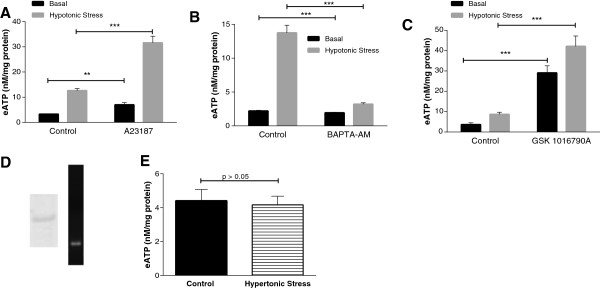
Roles of Ca2+ signaling and transient receptor potential vanilloid 4 (TRPV4) channels in hypotonically-induced release of eATP from chondrocytes. For the following experiments, chondrocytes were incubated with each additive for 30 minutes in 100 μl of media with no additives acting as a control. A hypotonic challenge was initiated by removing 35 μl of media, replacing it with 35 μl of H2O. eATP levels were measured after 10 minutes. Bars represent mean ± standard error. Under control conditions, a hypotonic challenge consistently increases (eATP). (A) Chondrocytes were incubated with 100 μM A23187, which increased eATP levels (n = 8; **P <0.01, ***P <0.001). (B) Chondrocytes were incubated with 10 μM bis-N,N,N',N'-tetraacetic acid-AM (BAPTA-AM), which decreased eATP levels after hypotonic challenge compared to control without BAPTA-AM (n = 8; ***P <0.001). (C) Chondrocytes were incubated with 100 nM GSK1016790A, which increased eATP levels in the basal state and after a hypotonic challenge compared to a control without GSK 1016790 (n = 8; ***P <0.001). (D) Chondrocyte protein extracts were run in western blots with TRPV4 antibody (leftpanel). mRNA for TRPV4 was detected with RT-PCR using a specific primer sequence and electrophoresed on a 1% ethidium bromide-stained agarose gel ( right panel). (E) Chondrocytes were incubated with control media (black bars) or media containing an additional 100 mM NaCl (gray bars) for 10 minutes after which eATP levels were measured. A hypertonic challenge did not increase eATP levels compared to the basal state (n = 8; P >0.05).